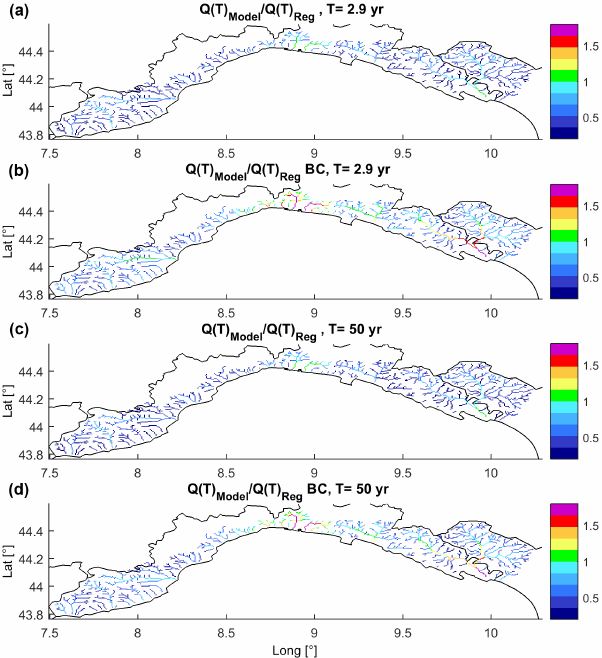
Figure 13. Maps of Ratio( T ) for T = 2 . 9 and 50 years. (a, b) shows results without rainfall bias correction and (c, d) (BC) with rainfall bias correction. The BC increases the percentage of drainage net- work points that have values around